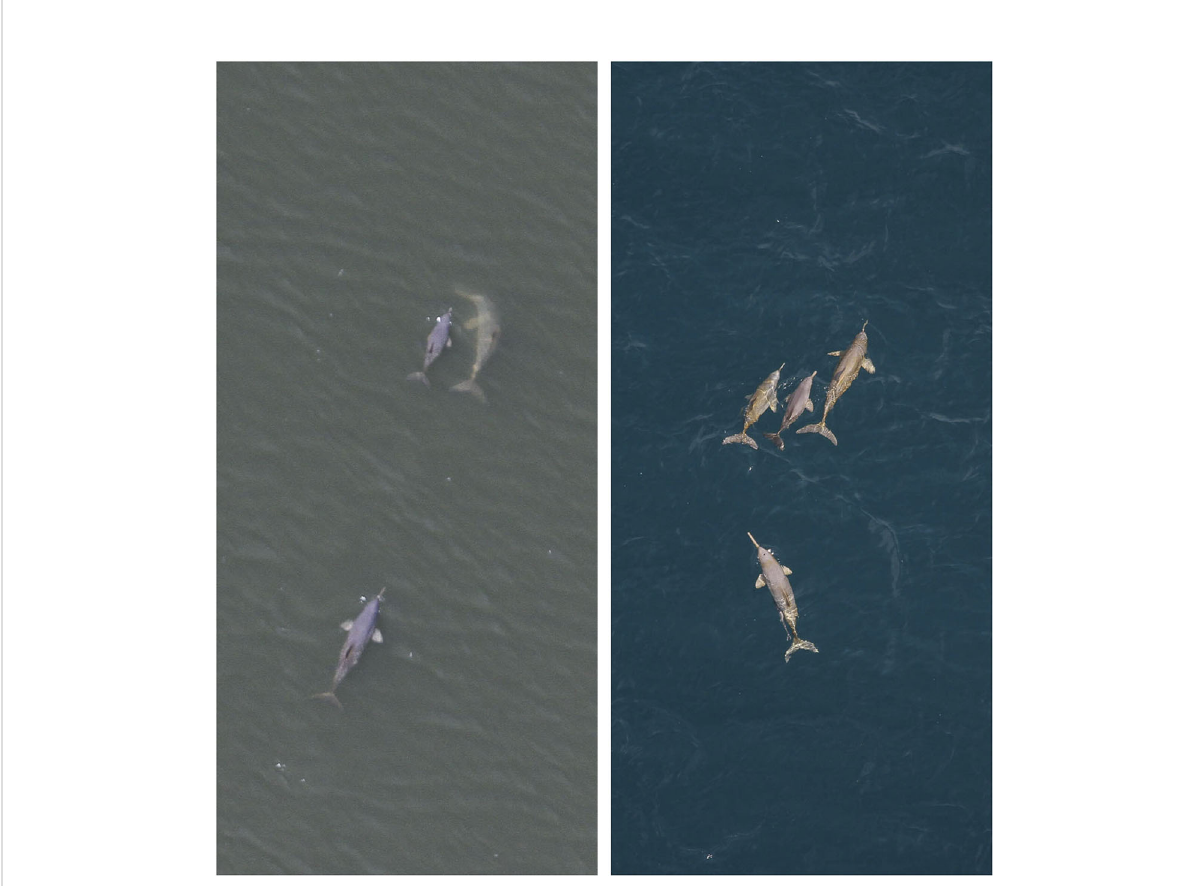
FIGURE 2 Franciscana ( Pontoporia blainvillei ) groups classi fi ed as available to detection from the air. Note differences in water turbidity between Babitonga Bay ( left - murky waters) and Ubatuba ( right - clear